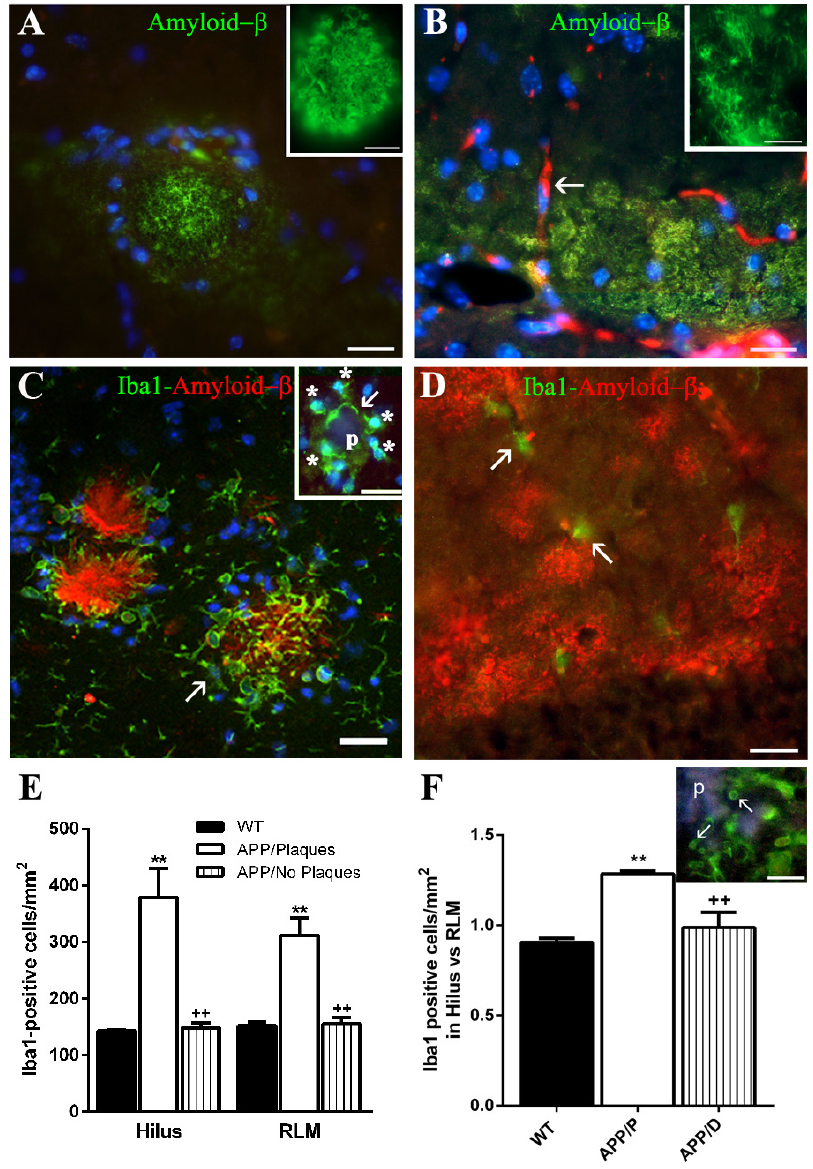
Figure 1. Microglia response to A β depends on the type of amyloid deposit to which they associate. ( A , B ) show the morphological differences between round and condensed A β plaques (( A ) and inset) and diffuse, fibrillar, and irregularly shaped A β deposits (( B )and inset) in the HP of 22-month-old APP. Note that cell nuclei disposition (stained with Hoechst in blue) is also different, since they surround the plaque in ( A ), but are dispersed in the diffuse deposits in ( B ).The arrow in ( B ) indicates the presence of erythrocytes (red autofluorescence) since this brain was not perfusion-fixed. ( C ) Confocal image showing the distribution of activated microglial Iba1-positive soma and processes surrounding or even penetrating (arrow) the plaques, which is rather different from the dispersed and not activated microglia in diffuse deposits shown in ( D ) (arrows). Note how the Iba1-positive processes (arrow) of five microglial cells (asterisks) embrace a small plaque (p) in ( C ), inset, and the Iba1-positive process loops indicative of phagocytosis in ( F ), inset (arrows). The graph in ( E ) shows that the density of microglial cells in APP/P is ~2.7 fold higher than in APP/D and WT.The graph in ( F ) reveals that the quotient between microglial density in hilus versus strata RLM is significantly higher (>1) in APP/P than in WT and APP/D. Results represent the mean ± SEM of 3 to 4 independent mice per experimental group. A one-way ANOVA followed by the Newman–Keuls test was performed. ** p ≤ 0.01 vs. WT. ++ p ≤ 0.01 vs. APP/P. Scale bars in ( A , B , D ): 20 µ m and in insets: 5 µ m; in C: 25 µ m and inset: 20 µ m; in F inset: 10 µ